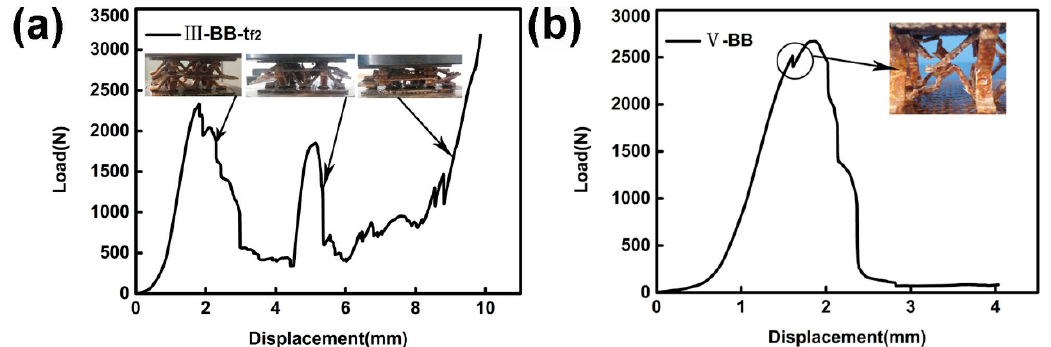
Figure 13. ( a ) The displacement–load diagram of sample III-BB- t f 2 ( b ) The displacement–load diagram of sample V-BB.